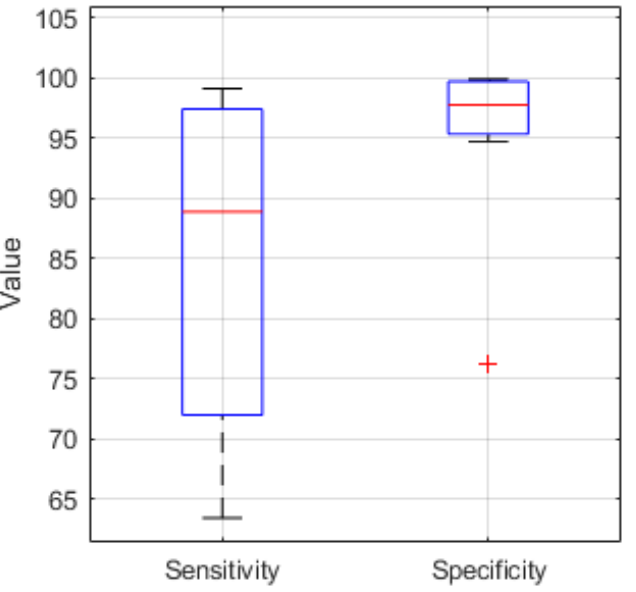
Figure 7. Sensitivity and Specificity boxplot (median value (red), lower and upper quartile (blue), min. and max. value (black), outlier (red cross)) for 10 EEG recordings classified in Python with a median sensitivity and specificity of 88.8% and 97.7%, respectively.